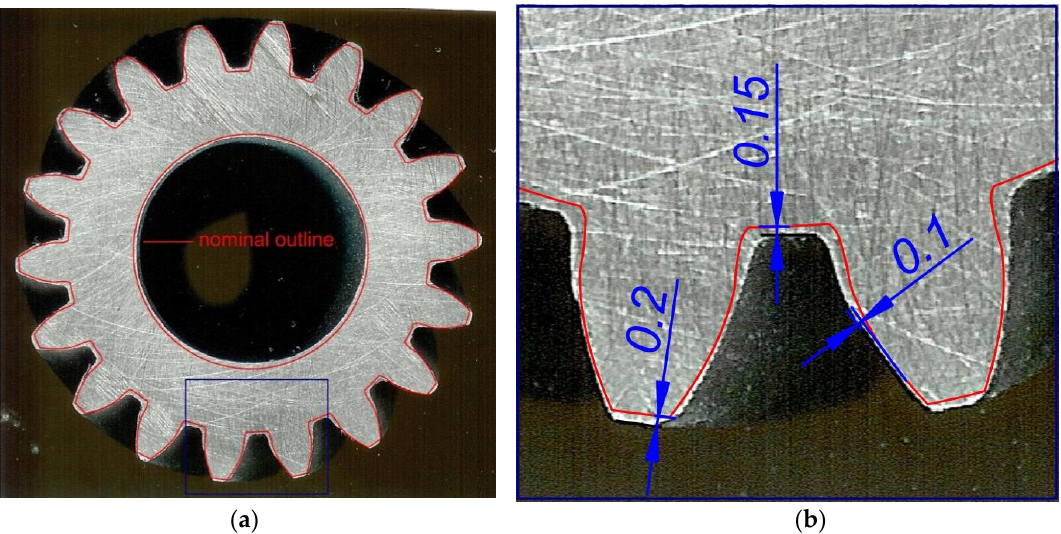
Figure 12. Experimental and FEM tooth profiles with material allowance: ( a ) cross section, ( b ) deviation outline teeth.